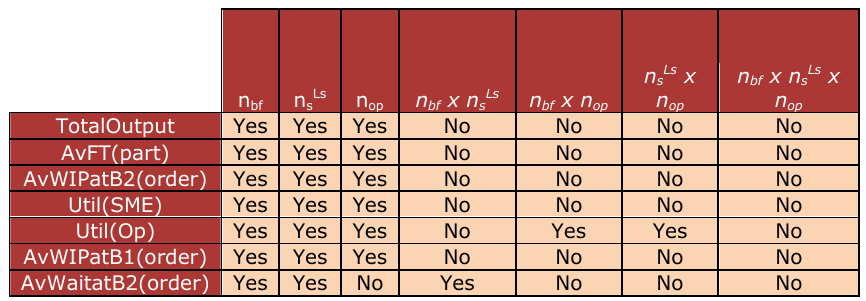
Table 4 . Summary of multi-factor ANOVA tables for the MRKS